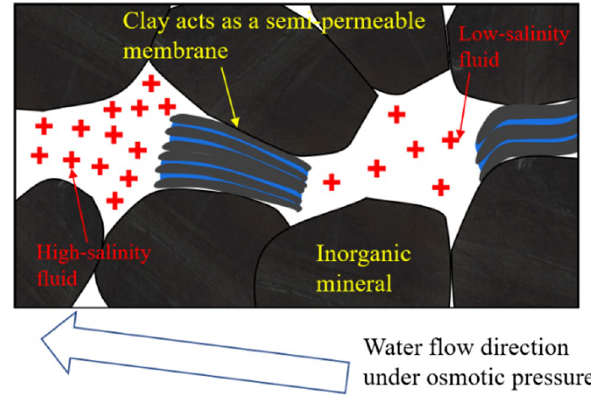
Fig. 9 Effect of osmotic pressure on external higher salinity